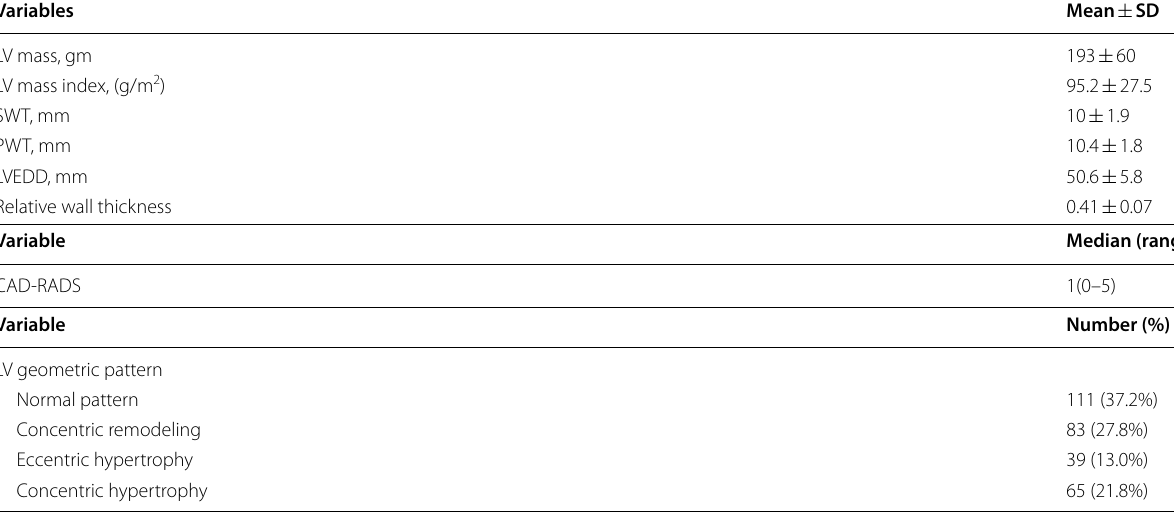
Table 3 Baseline CT data of the study population